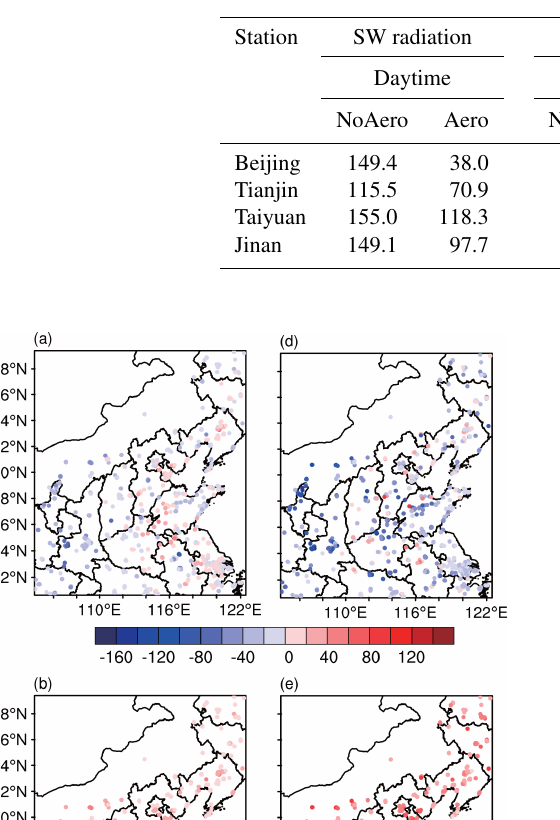
Table 2. Mean bias of downward SW radiation at the surface (Wm − 2 ) and net radiation at the surface (Wm − 2 ) from NoAero and Aero relative to observation during the daytime (averaged 08:00 to 18:00LT) and nighttime (averaged 19:00 to 07:00LT), averaged from 6 to 11 December 2015 in Beijing, Tianjin, Taiyuan and Jinan respectively.